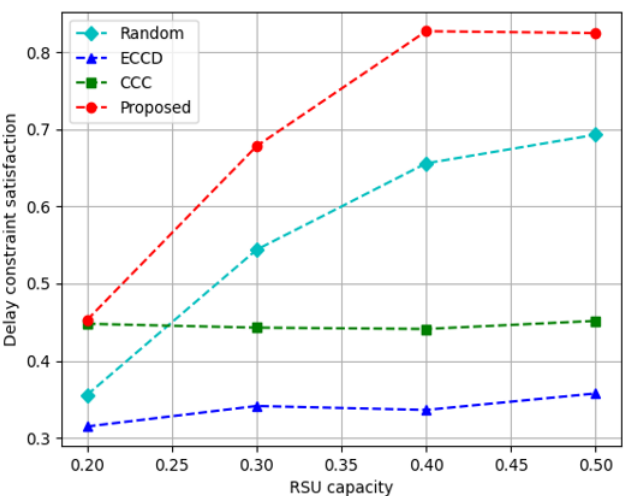
Figure 11. Delay constraint satisfaction according to the increase in the capacity of RSUs.